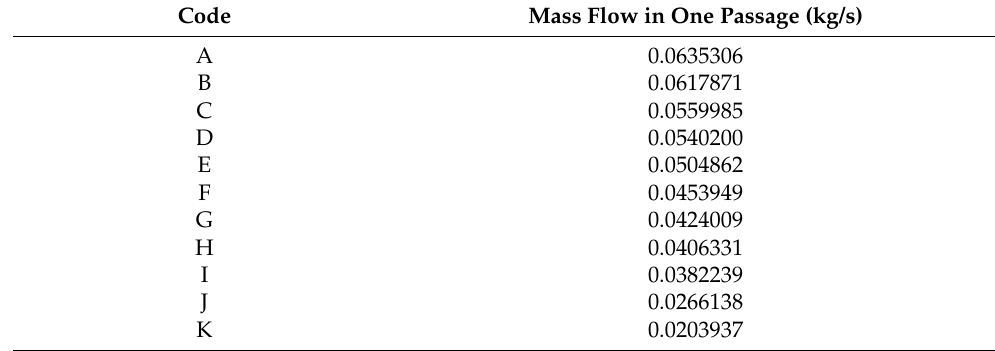
Table 1. Simulated mass flow rates.